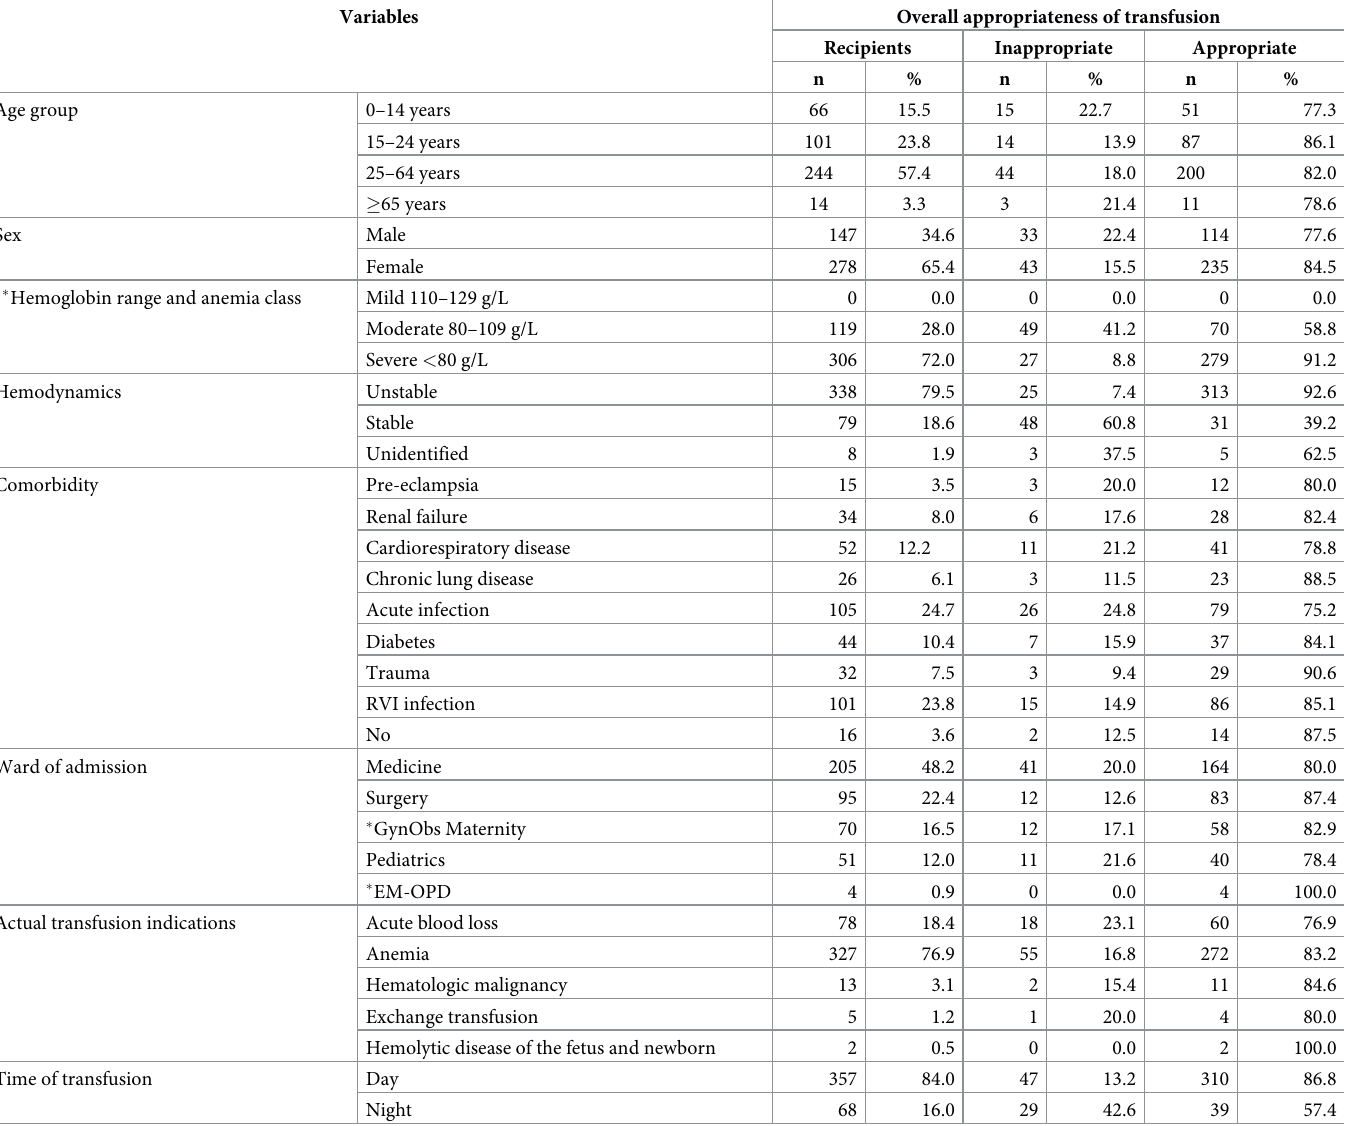
Table 5. Blood transfusion practice appropriateness distribution according to demography and clinical variables at JMC, southwest Ethiopia, February 1 to June 30, 2018 (n = 425). Variables Overall appropriateness of transfusion